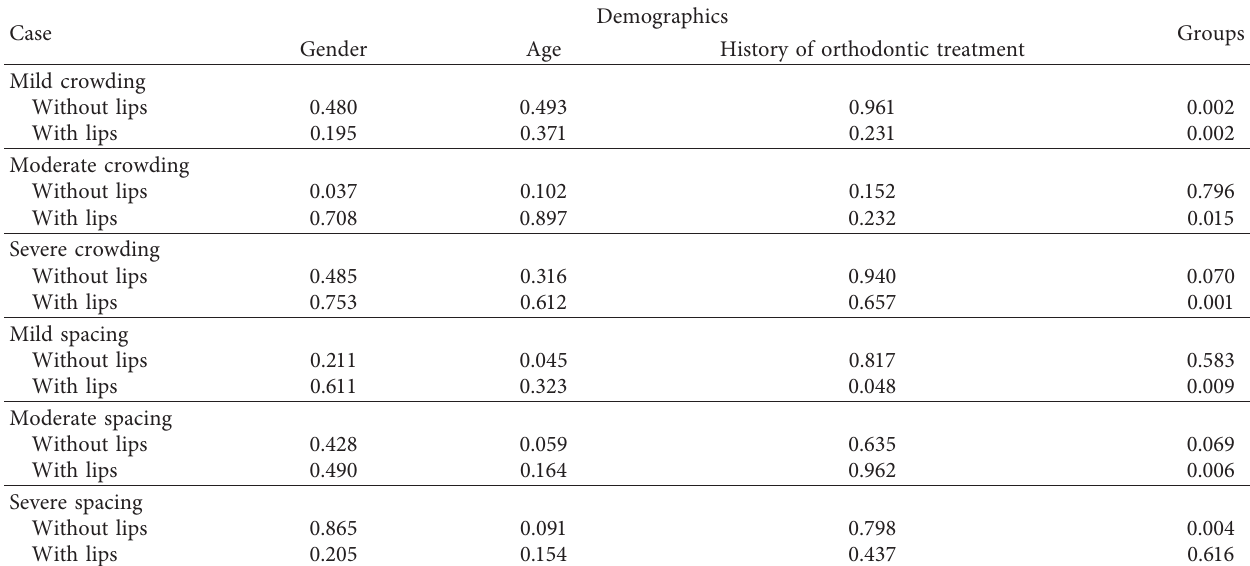
Table 2: Differences in the perception of attractiveness of anterior crowding and spacing with and without upper lips position and according to demographic characteristics and